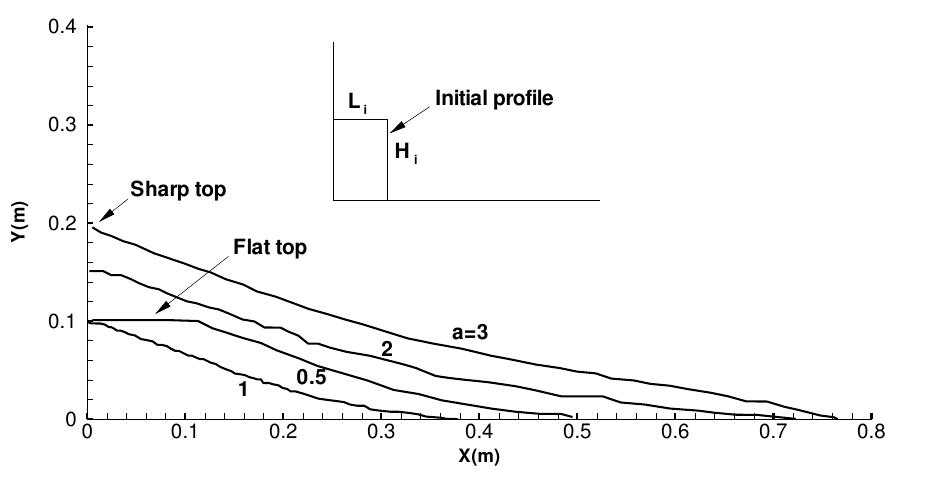
Figure 6. Dry granular column collapse with different aspect ratios ( a = H i / L i = 0.1/0.1,0.2/0.1,0.3/0.1,0.1/0.2, respectively).